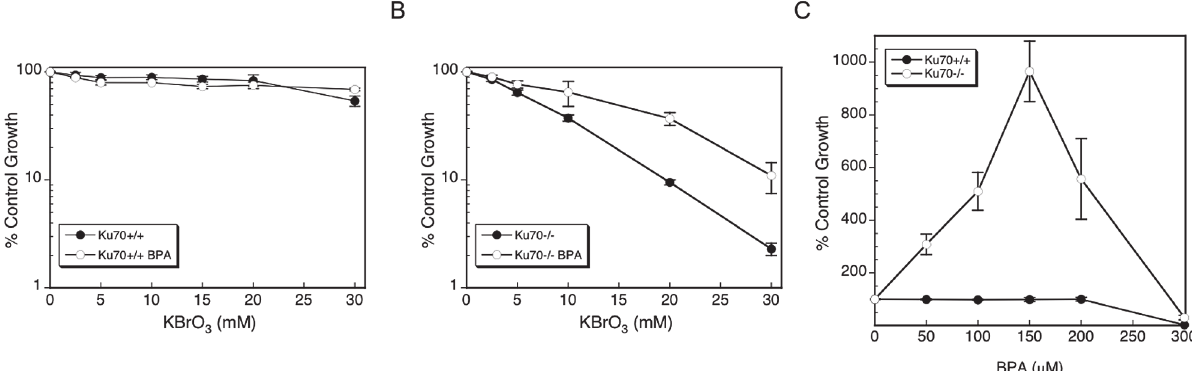
Fig 1. Cell survival following co-exposure of BPA and KBrO 3 . Ku70-proficient (A) and-deficient (B) cells were treated for 1 h with the oxidizing agent, KBrO 3 , with and without pre-treatment with 150 μ M BPA for 1 h prior to induction of KBrO 3 -induced DNA damage. Exposure to BPA was for a total of 24 h (see Materials and Methods). (C) Dose of BPA required for maximal protective effect. For determination of the dose of BPA that produces the maximal protective effect against 20 mM KBrO 3 , Ku70-proficient and-deficient cells were treated with increasing doses of BPA for 1 h, co-exposed with KBrO 3 for 1 h, and then the BPA exposure was continued for a total of 24 h (see Materials and Methods). The results are expressed as the number of cells in BPA-treated wells relative to number of cells in wells treated with KBrO 3 alone.